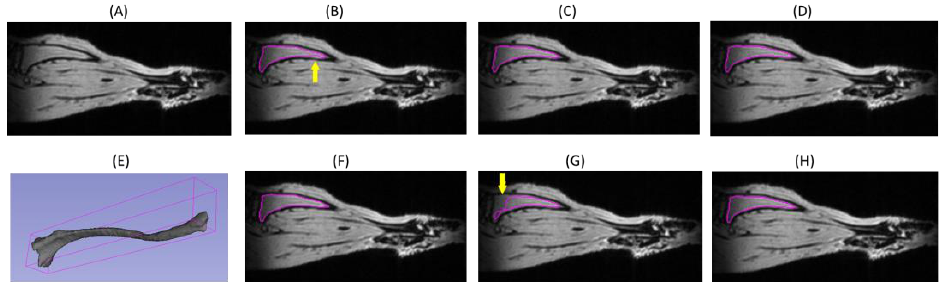
Figure 4. Examples of mouse tibia segmentation contours (magenta) for a single-slice MRI image in the test set ( A ) delineated by expert annotators (( B ) EA1; ( F ) EA2) and by DL model with different training scenarios ( C ) full training; ( D ) TS1; ( G ) TSM; ( H ) TS2). ( E ) The full tibia 3D volume (6.5 mm 3 ) segmentation by EA1. The yellow arrows indicate apparent tibia under-segmentations in ( B ) and ( G ).